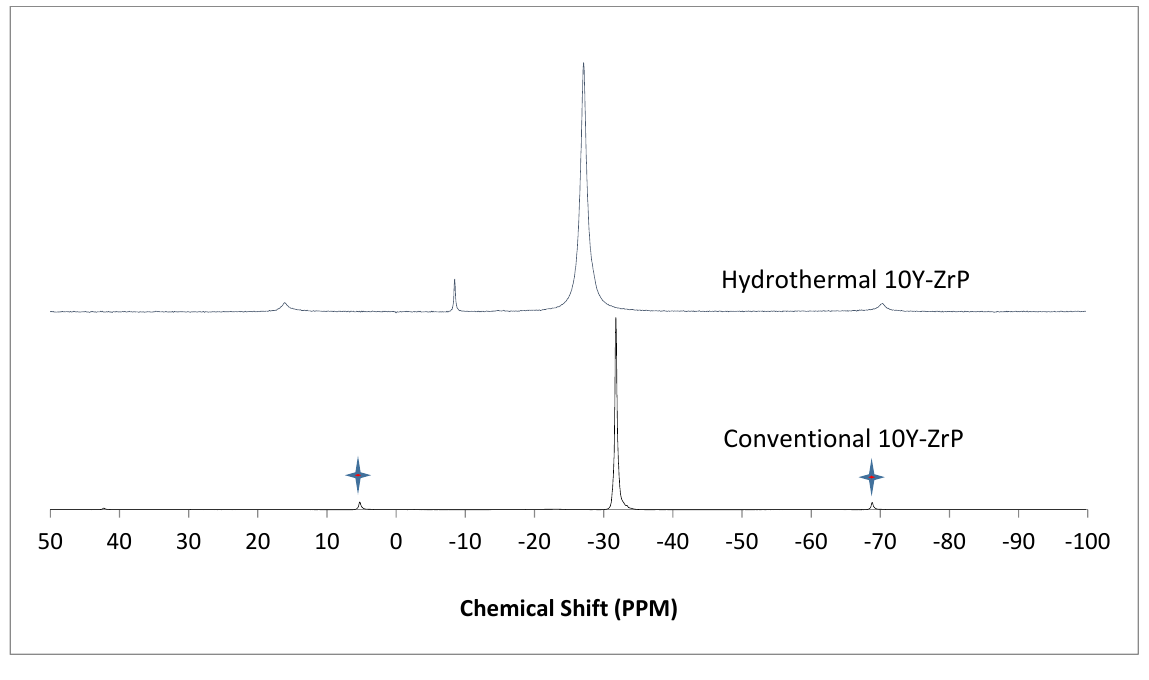
ChemEngineering 2021 , 5 , x FOR PEER REVIEW Figure 8. 31 P NMR of 10Y-ZrP synthesised using the two described methods (spinning side bands are shown as ). Figure 8. 31 P NMR of 10Y-ZrP synthesised using the two described methods (spinning side bands are shown as Figure 8. 31 P NMR of 10Y-ZrP synthesised using the two described methods (spinning side bands are shown as ).